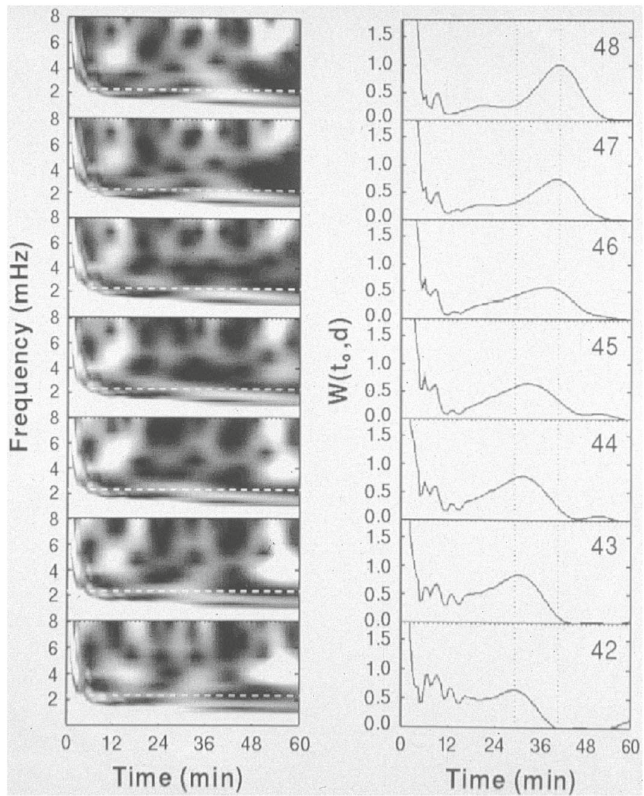
Fig. 18 Left: time–frequency diagrams of the Doppler velocity at several aligned, equispaced points in a quiescent prominence. White/black correspond to large/small wavelet power. Right: time variation of waveletpowerfromthediagramsontheleftcolumnforaperiodof7.5min(i.e.,frequencyaround2.2mHz). The presence of power peaks suggests a finite duration of the perturbation, while the linear displacement of these peaks at the seven positions from t = 28 min to t = 42 min is an indication of a disturbance travelling with a group velocity v g ≥ 4 . 4 km s − 1 . Image reproduced with permission from Molowny-Horas et al. (1997), copyright by